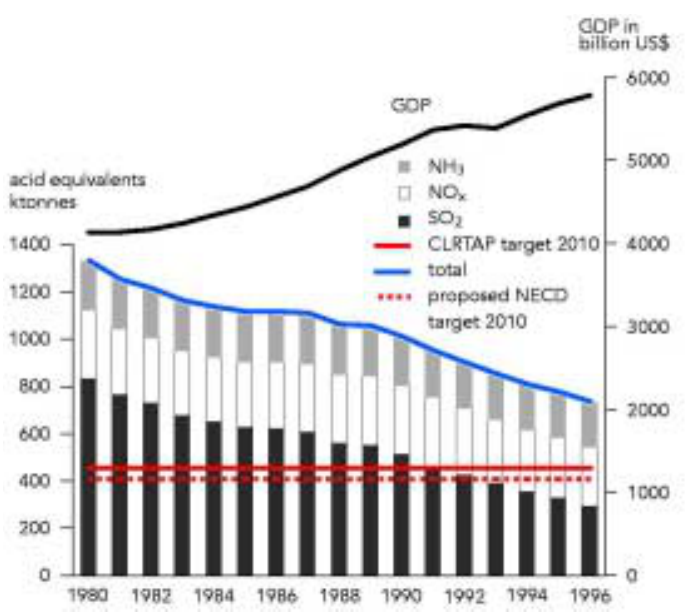
FIGURE 2. Trend in European emissions (Mton S or N). Source: